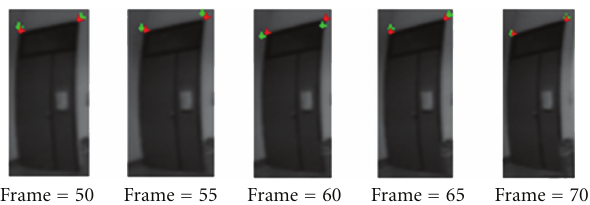
Figure 3: Detect the actual target pixel location by using cross- correlation